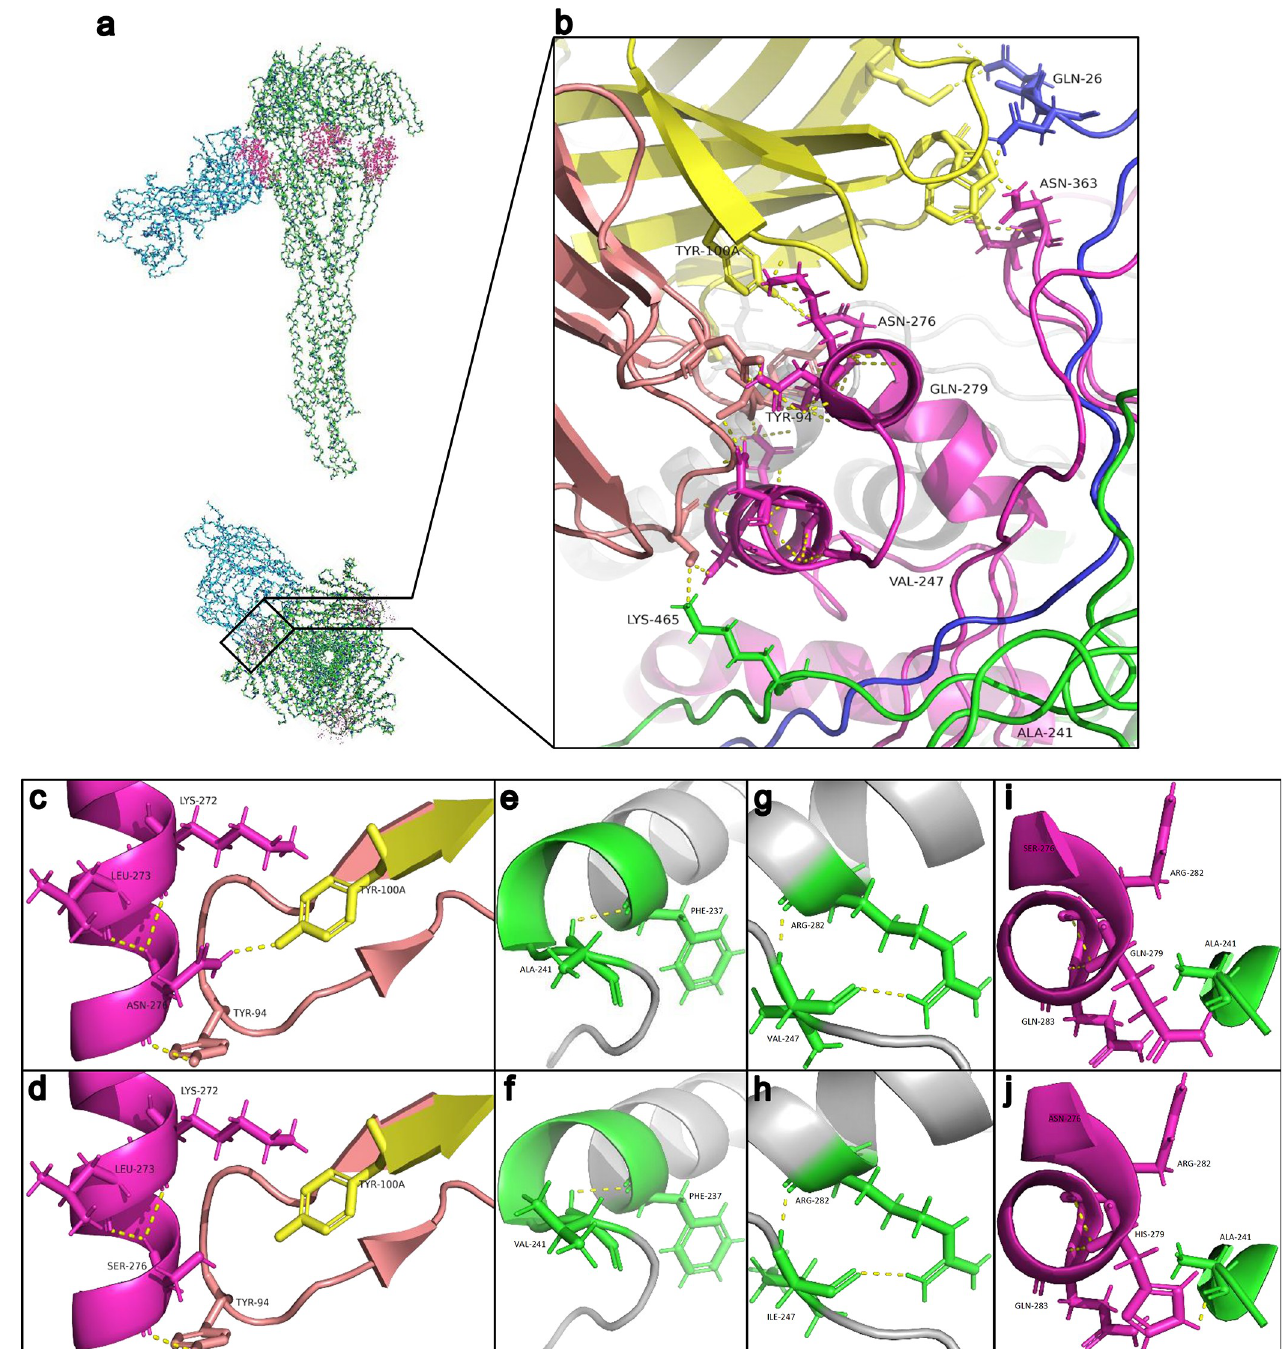
Fig 4. Structural elucidation of the interactions between F glycoprotein and palivizumab. (a) Predicted structure of the RSV-A postfusion F glycoprotein (PDB: 3RRT) bound to palivizumab Fab fragment (PBD: 2HWZ). Pink dots, antigenic site II (amino acid residues 258–275); upper panel, side view; lower panel, top view. (b) Predicted interface of polar inter-chain interactions between the RSV-A postfusion F glycoprotein antigenic site II and Fab fragment of palivizumab. The location of the four residues (Ala241, Val247, Asn276, Gln279) on the F glycoprotein for which mutations were observed in the Lebanese strains are shown. (c) Polar contacts by Asn276 in the RSV-A F glycoprotein vs (d) showing disappearance of a 2.3 Å polar bond with Tyr100 on Fab H chain due to the N276S substitution while maintaining the 2.9 Å polar bond with Tyr94. (e) Polar contacts by Ala241 in the RSV-A F glycoprotein vs (f) showing no changes of polar interactions with the A241V substitution. (g) Polar contacts by Val247 in the RSV-A F glycoprotein vs (h) showing no changes of polar interactions with the V247I substitution. (i) Polar contacts by Q279 in the RSV-B F glycoprotein vs (j) showing the appearance of a new 1.6 Å polar bond with Ala241 on an adjacent chain of the F glycoprotein due to the Q279H substitution. Yellow, palivizumab Fab heavy chain; orange, palivizumab Fab light chain; magneta, F glycoprotein F chain; blue, F glycoprotein E chain; green, F glycoprotein B chain; yellow dashed lines, polar contacts. https://doi.org/10.1371/journal.pone.0212687.g004 PLOS ONE | https://doi.org/10.1371/journal.pone.0212687 February 21,